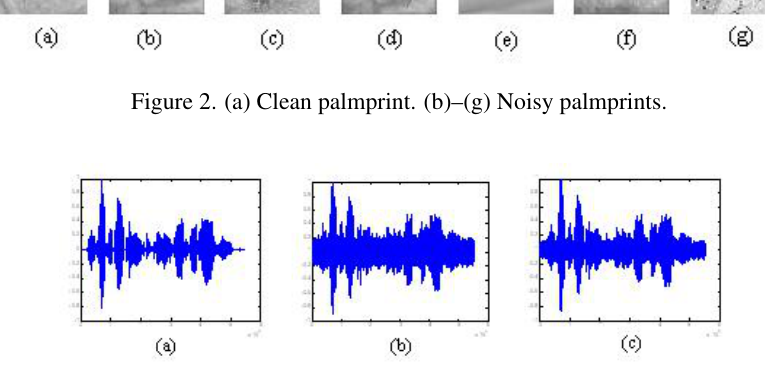
Figure 3. (a) Clean speech. (b) Noisy speech (4 dB). (c) Noisy speech (8